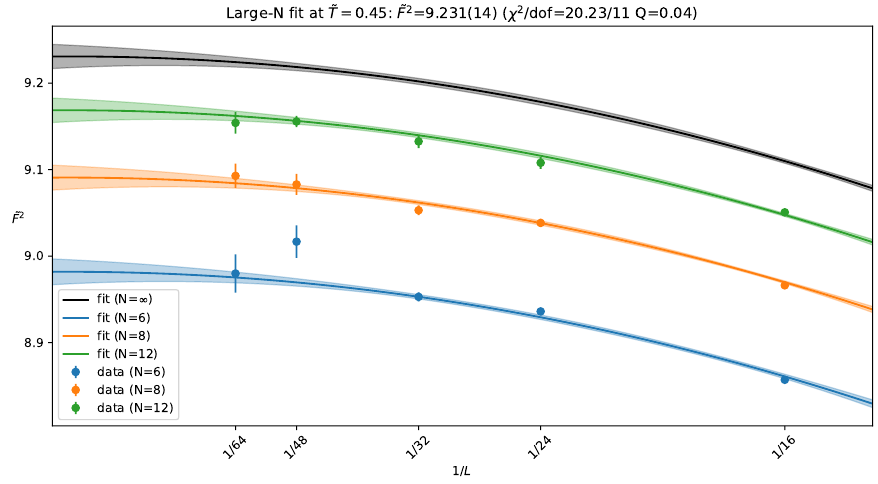
~ E=N 2 for the bosonic ungauged 3